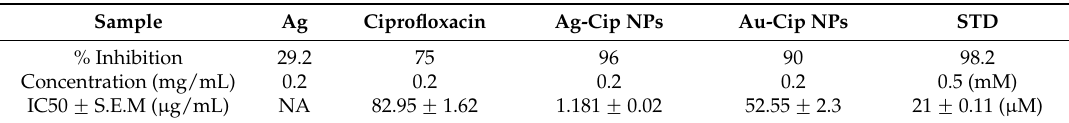
Urease enzymes inhibition studies of Ag, ciprofloxacin, and ciprofloxacin-capped Ag/Au